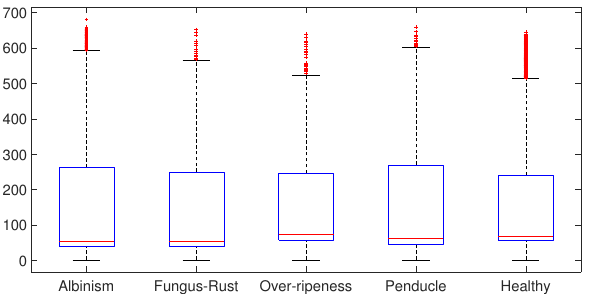
Figure 12. Boxplots of each class show a generalized symmetry, and no significant